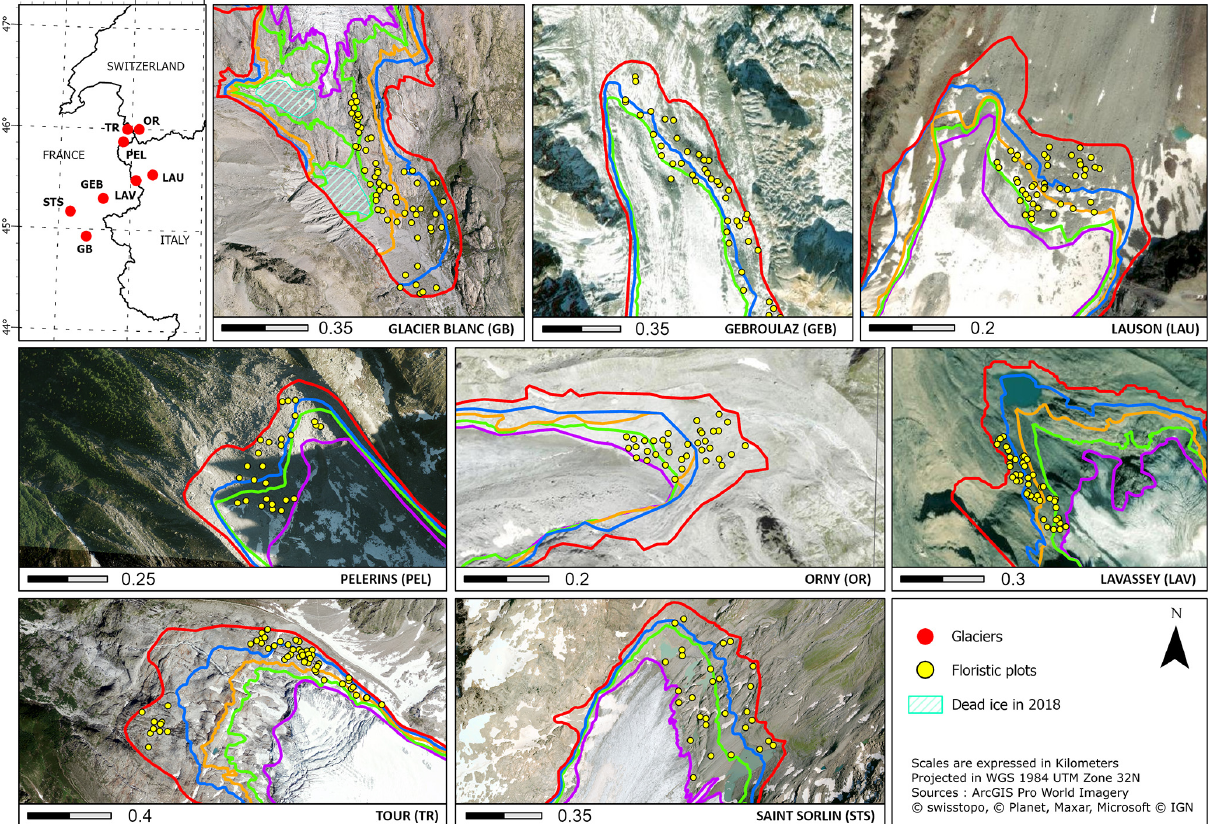
Figure 1. Distribution of the eight glacier margins in France, Switzerland, and Italy with corresponding abbreviations. Floristic plots are indicated as yellow points, while glacier outlines are shown as thick colored lines. Colors do not indicate similar outline dates but chronose- quences of deglaciation. Corresponding years of deglaciation is to be found in Table S1. Projection and source details are indicated in the